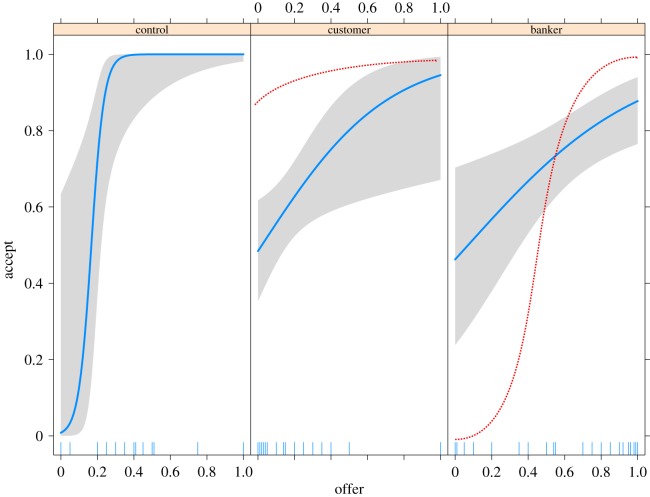
Pilot data. Plot of logistic regression of responders' acceptance probability as a function of offer amount by condition (grey shaded areas indicate 2 s.e., rug indicates offers). Dotted red line overlay indicates our predicted trends for responder acceptance probability in the treatment conditions.